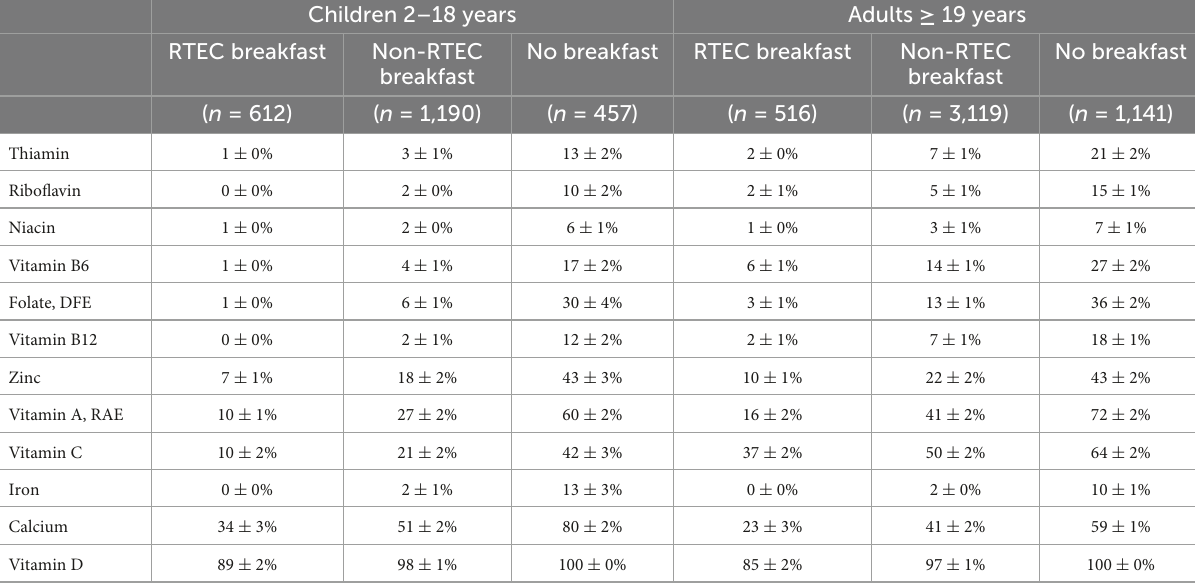
TABLE 3 Percent below estimated average requirement (EAR) in US children and adults by breakfast status, National Health and Nutrition Examination Survey, 2017–2018. Children 2–18